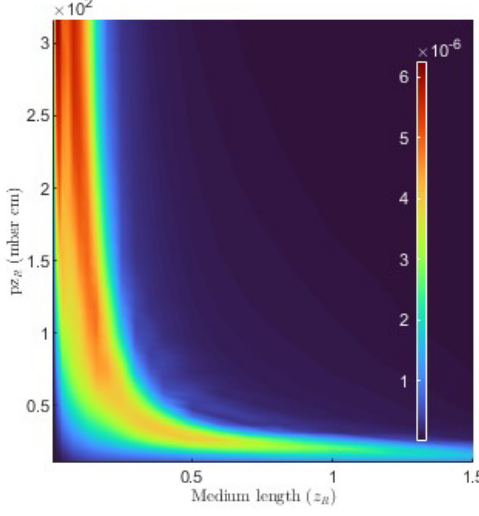
Figure 1. Conversion efficiency of the 23 rd har- monic of 800 nm radiation generated in argon at an intensity of 2.5 x10 14 W/cm 2 . z R denotes the Ray- leigh length. Adapted from